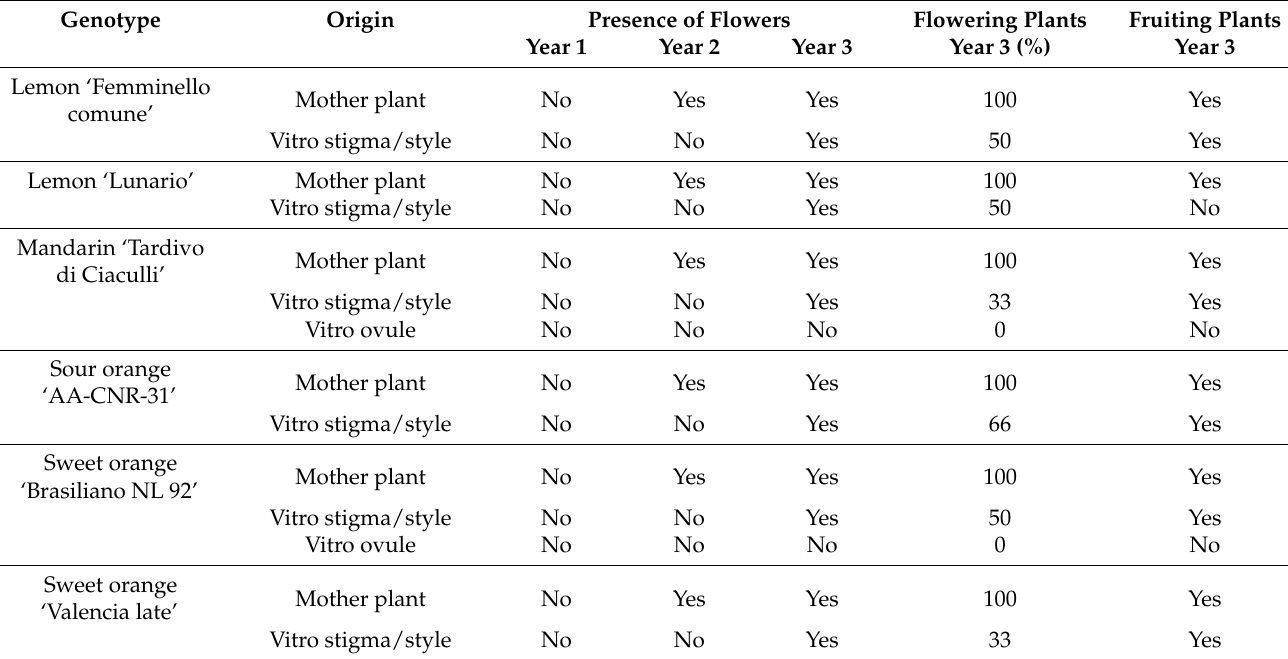
Table 2. Observations on flowering plants in